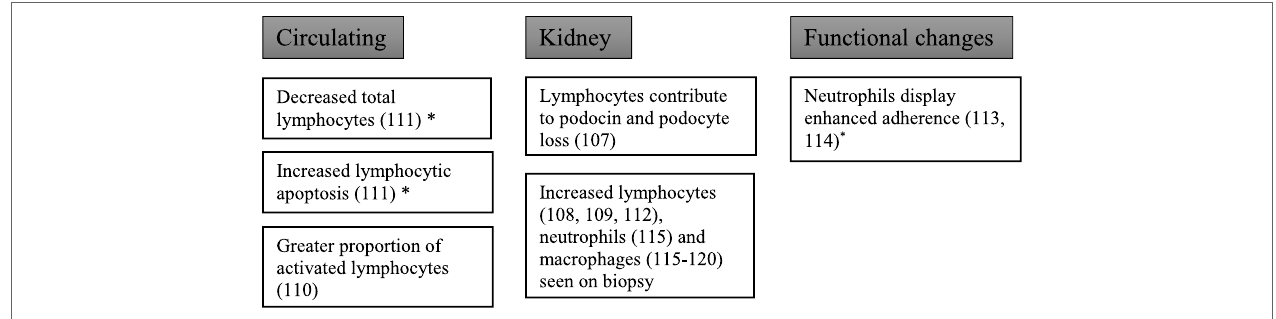
FiGURe 4 | Changes to leukocytes in diabetic kidney